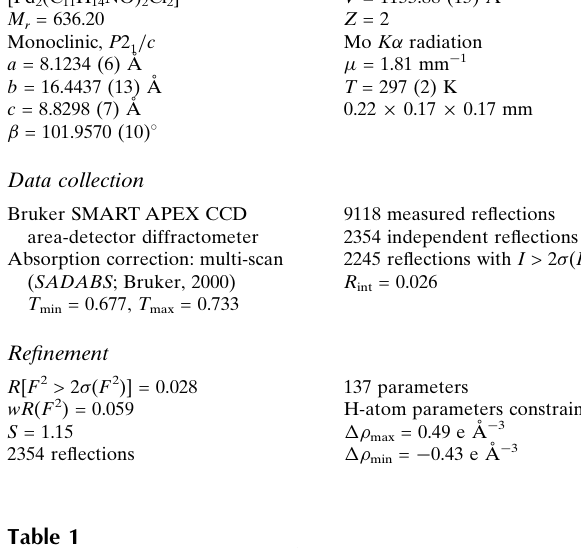
Selected geometric parameters (A˚ , (cid:2) ).